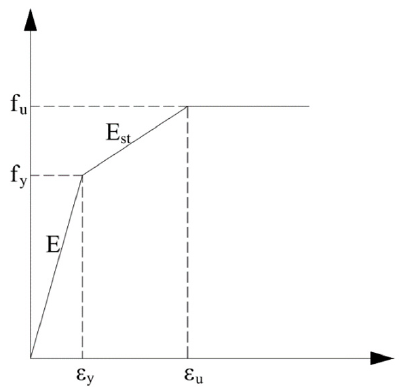
Figure 8. Material constitutive model.